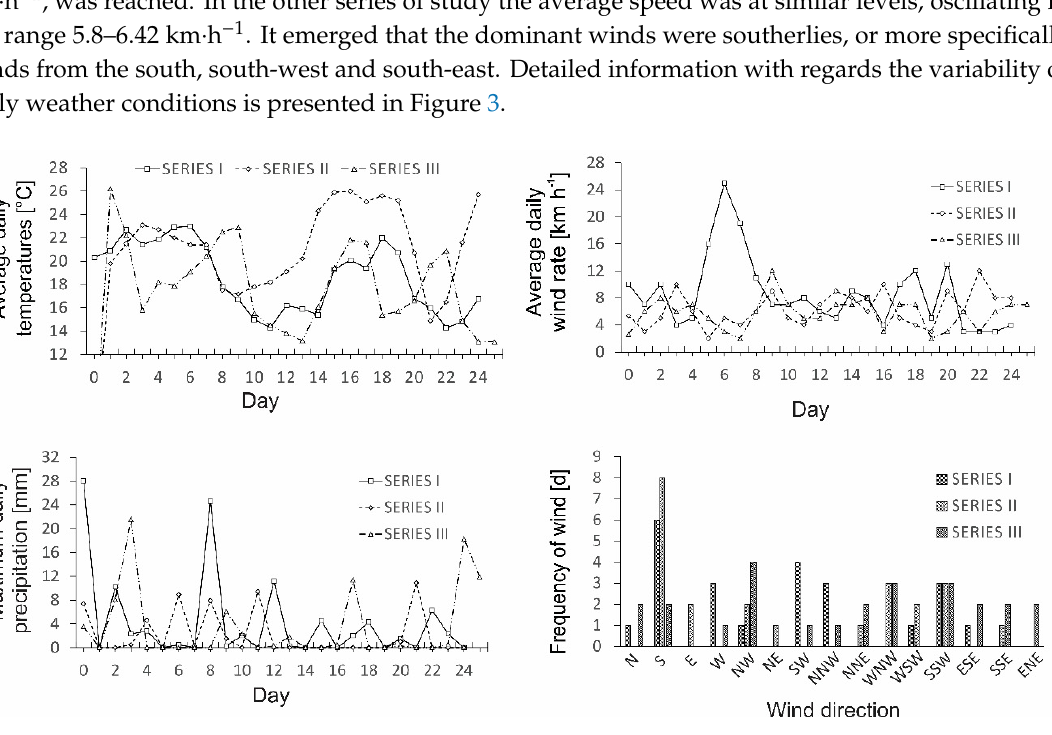
Figure 3. Variability of atmospheric conditions during the study.